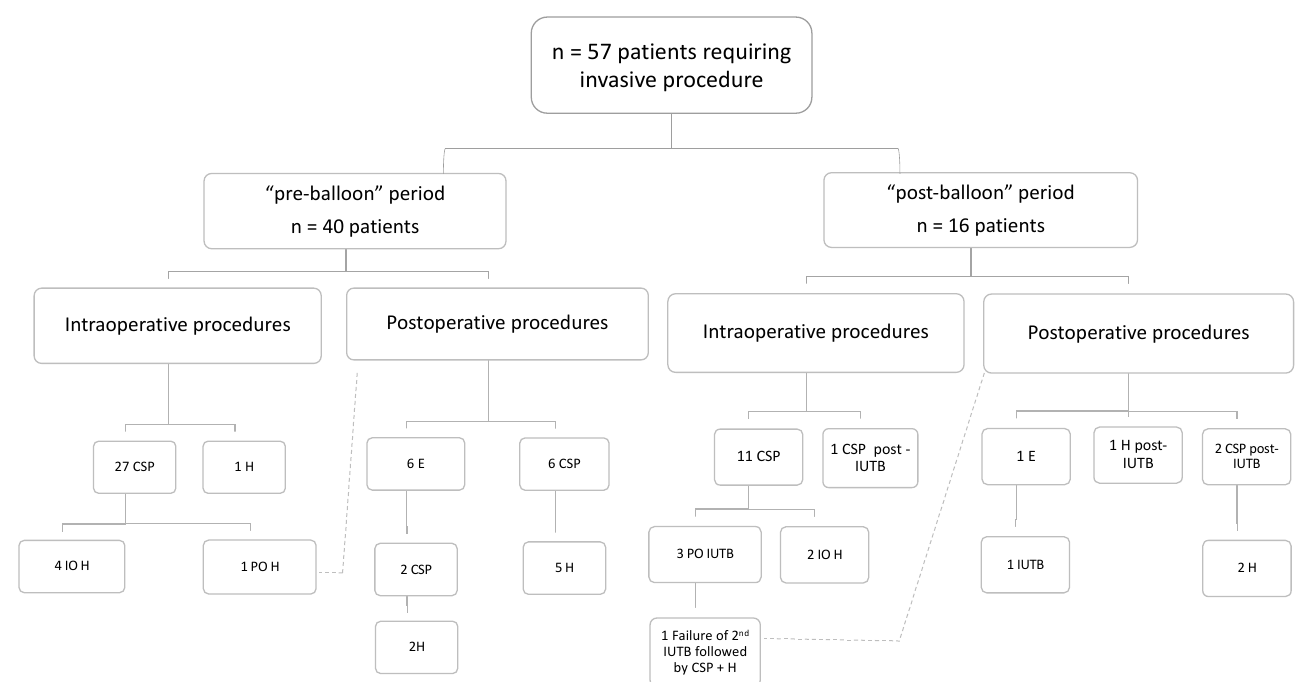
Figure 2. Flow chart representing the timing (intraoperative/postoperative) at which each invasive procedure (CSP, E and/or H) was performed. CSP: conservative surgical procedure; H: hysterectomy; E: uterine artery embolization; IO: intraoperative; PO: postoperative. In one patient for each period, an invasive procedure was used intraoperatively and another one followed postoperatively (a dash line links both procedures). Of note, the detailed use of the intra-uterine tamponade balloon (IUTB) during the “post-balloon” period and its timing versus the invasive procedure is displayed in Figure 3.